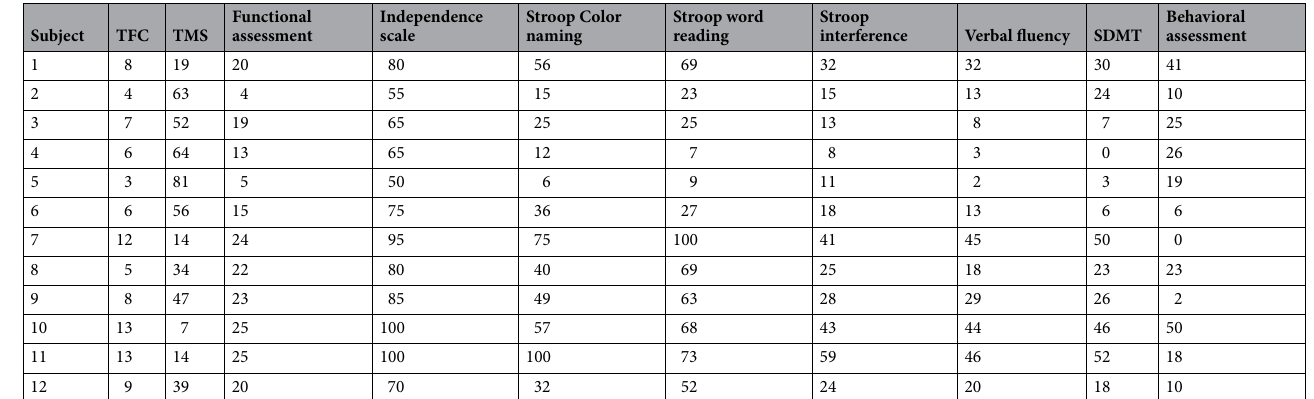
Table 2. Participant unified Huntington’s disease rating scale